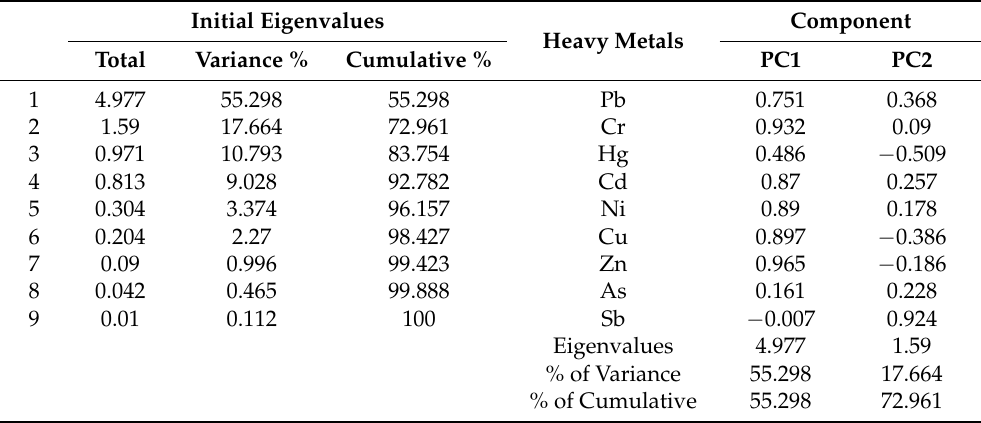
Table 4. Principal component analysis for heavy metals detected in the surface sediments of Lake Yangcheng. Initial Eigenvalues Heavy Metals